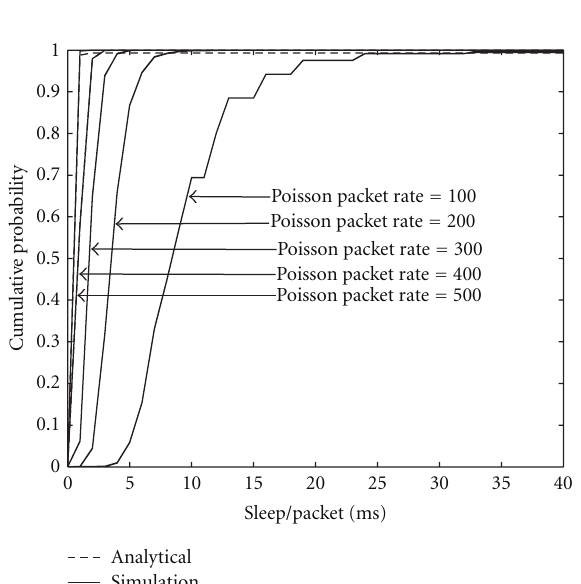
Figure 10: Average packet delay.